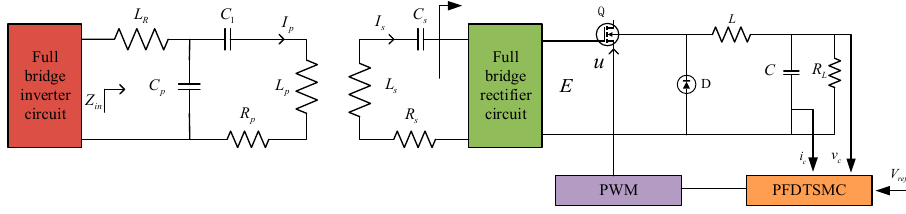
Figure 6. Power type fast discrete terminal sliding mode control.